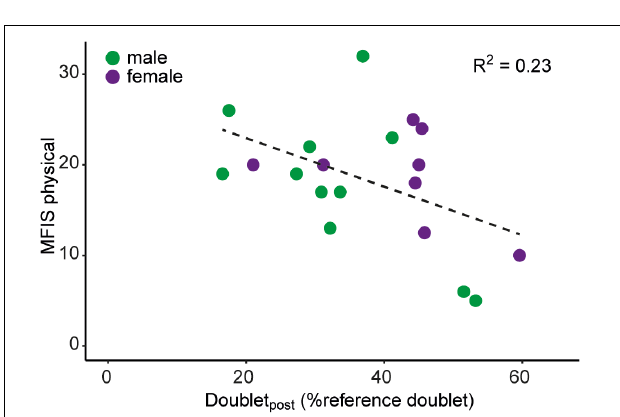
FIGURE 4 | Time course of the superimposed twitches during the sustained MVC. Dots show the mean size of the superimposed twitches evoked before ( t = 0 s) and during the sustained MVC ( t = 7–115 s). Control data ( n = 20) is shown in blue and mTBI ( n = 20) in red. Error bars indicate the standard deviation. Superimposed twitches were linearly corrected for the decline in muscle force and expressed as a percentage of the doublet pre .